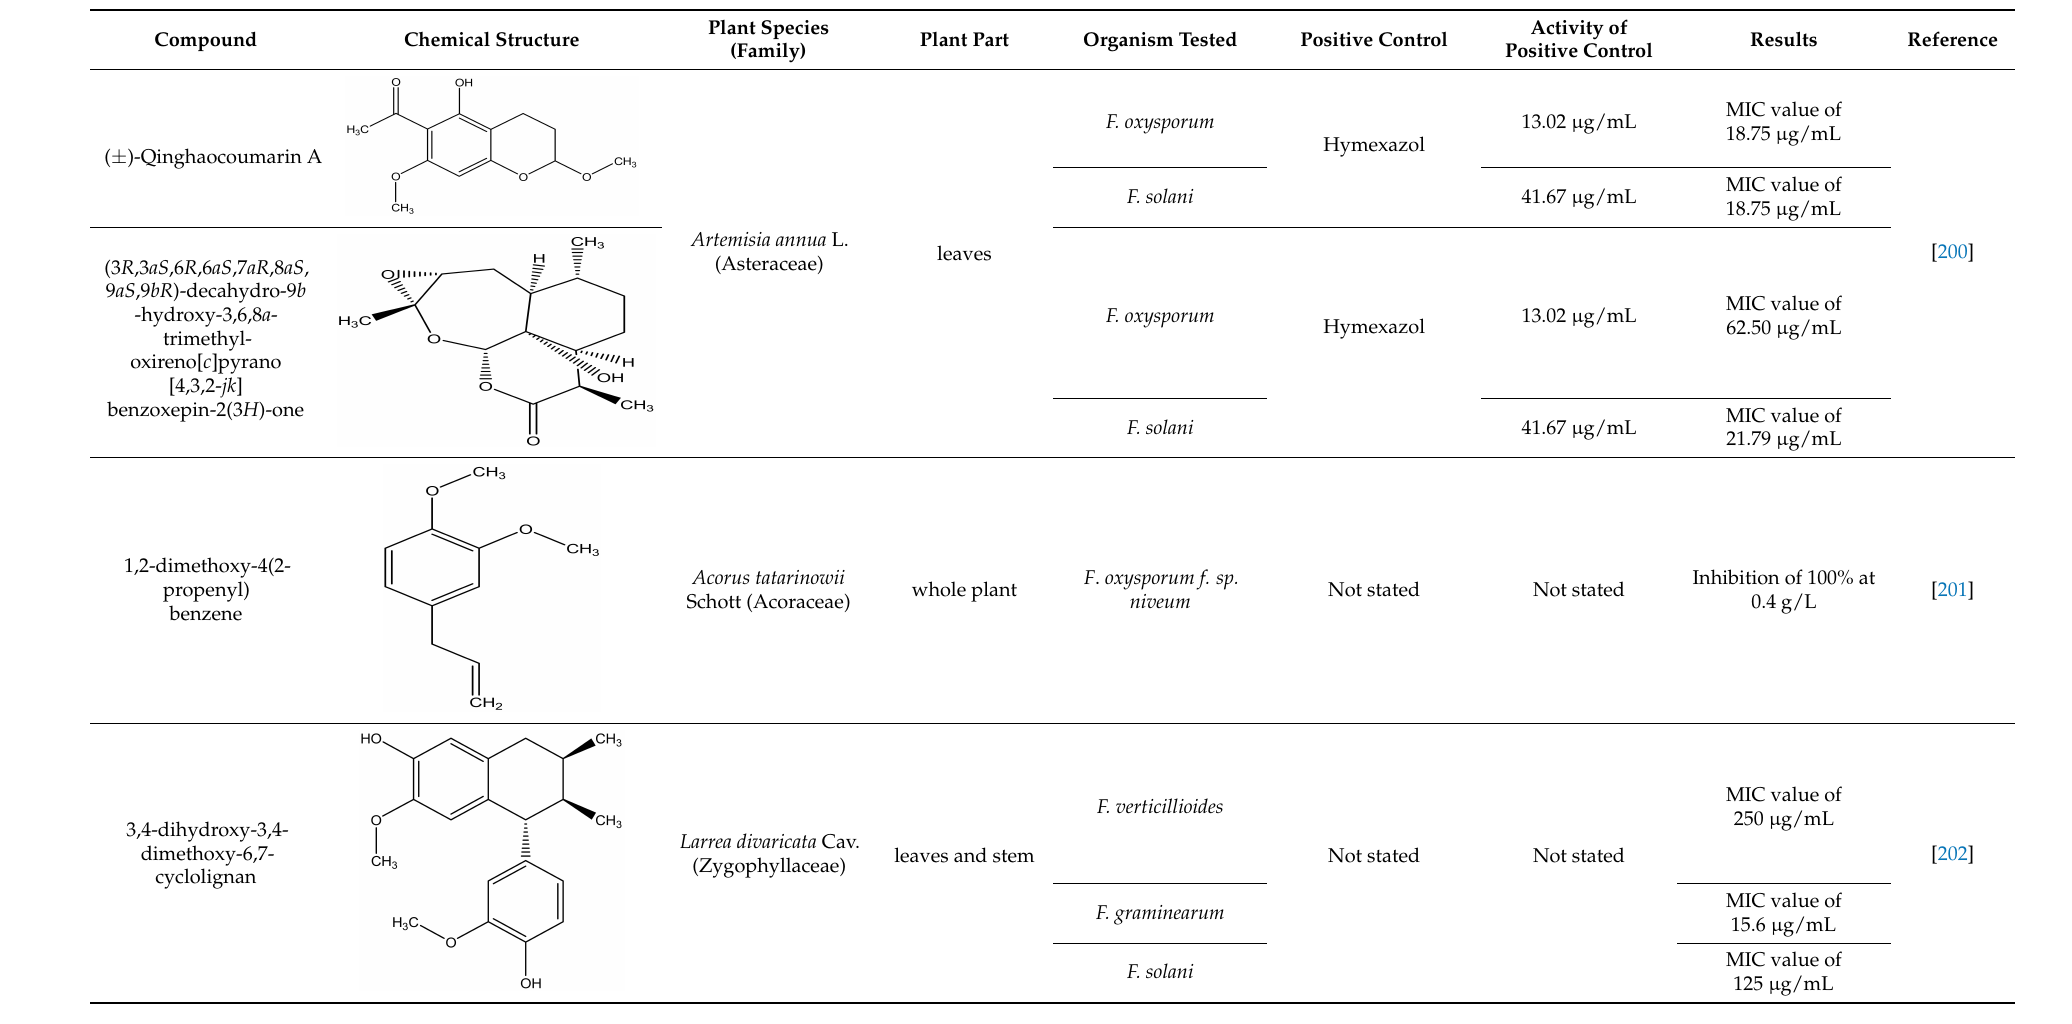
Table 4. Antifungal activity of compounds isolated from plants used in traditional medicine. The compounds were evaluated against different Fusarium pathogens and their antifungal activities were reported as minimum inhibitory concentration, percentage inhibition or half-maximal effective